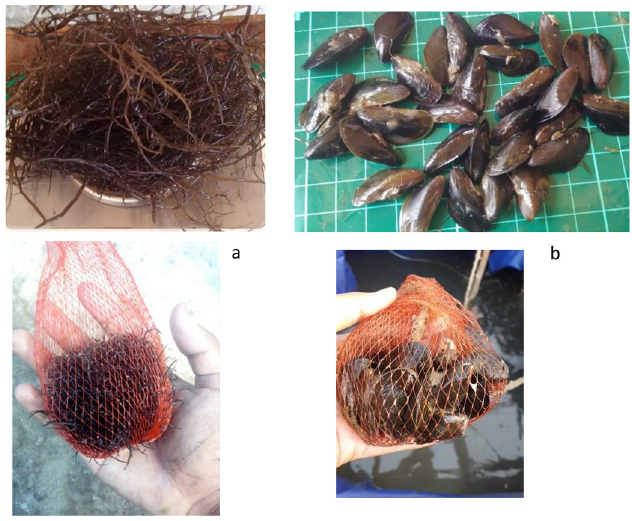
Fig. 1. G. verucosa (a) and P. viridis (b) were cultured by the hanging